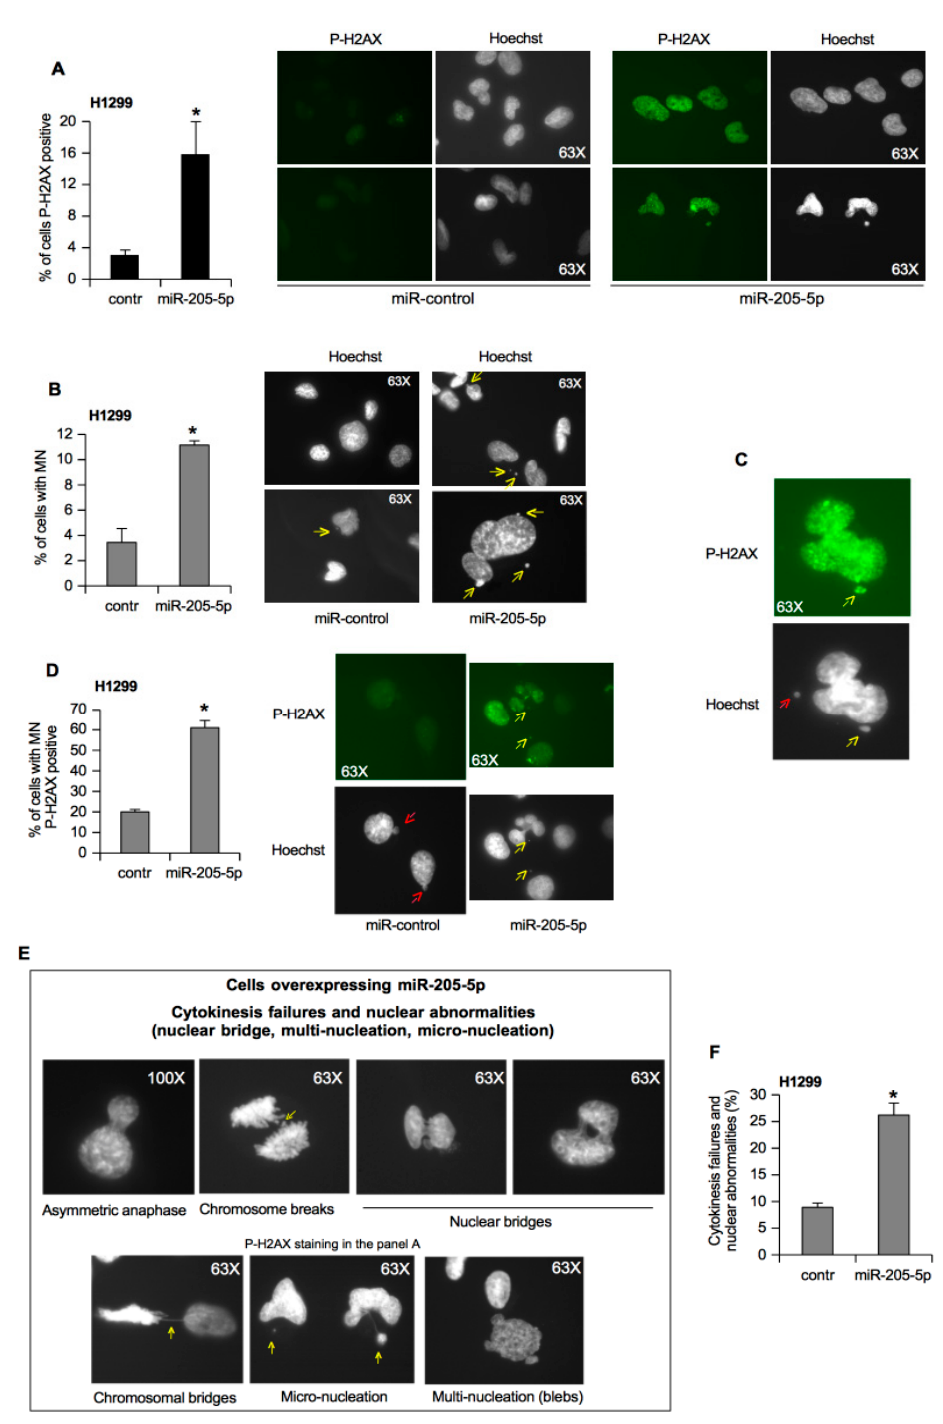
Figure 4. MiR-205-5p involvement in genomic instability. ( A ) H1299 cells were transfected with mimic miR-205-5p and mimic control oligos. Subsequently, cells were stained for P-H2AX 48 h after miR-205-5p and mimic control oligo overexpression. Representative images and quantification of unrepaired double-strand breaks (DSBs) are shown. Hoechst was used for nuclear staining. The p -values were calculated with a two-tailed t -test. Statistically significant results had a p -value < 0.02 (*). Data represent the mean ± SD from three biological replicates. ( B ) H1299 cells overexpressing miR-205-5p and a mimic control were observed on the basis of micronuclei (yellow arrows). The percentage of 500 cells scored by each point is reported. The p -values were calculated with a two-tailed t -test. Statistically significant results had a p -value < 0.02 (*). Data represent the mean ± SD from three biological replicates. ( C ) Examples of micronuclei (MN)-P-H2AX ( + ) (yellow arrow) and MN-P-H2AX ( − ) (red arrow)